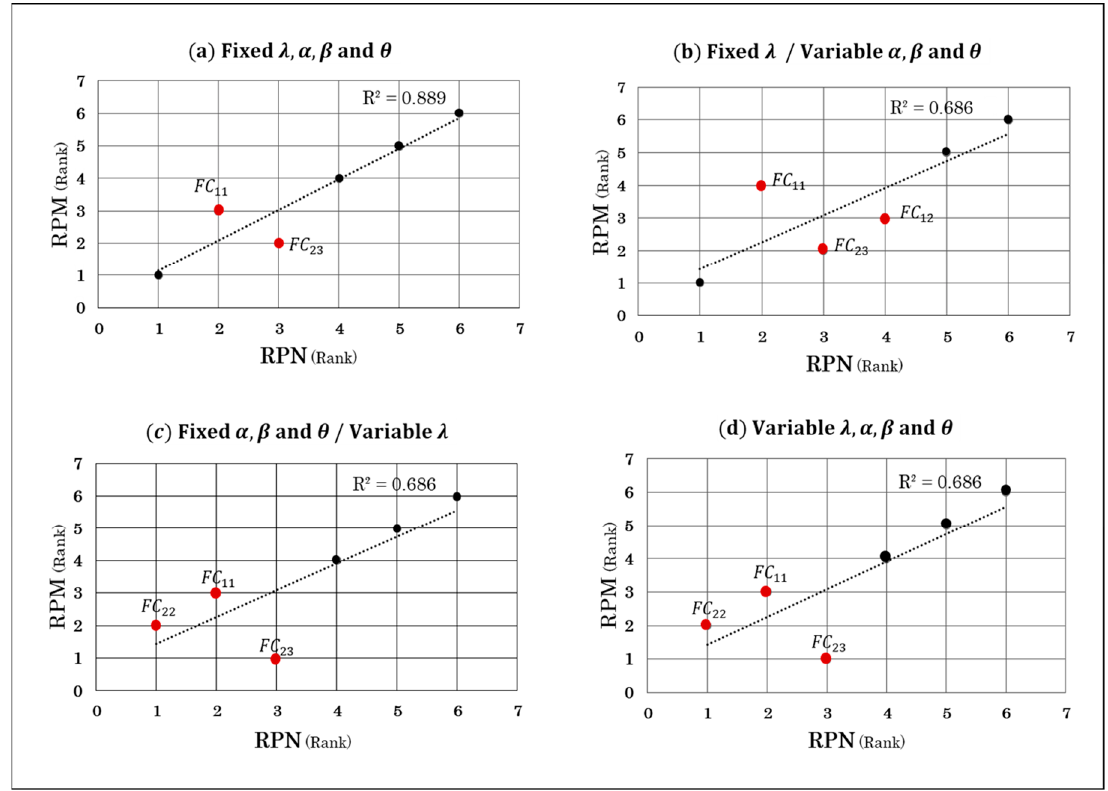
Figure 4. Rank correlation between RPM and RPN obtained by design FMEA: RPM and RPN are strongly correlated except for slight variations in priority rank. In this case, square root of R 2 is Spearman correlation coefficient, i.e., Pearson correlation coefficient of rank.